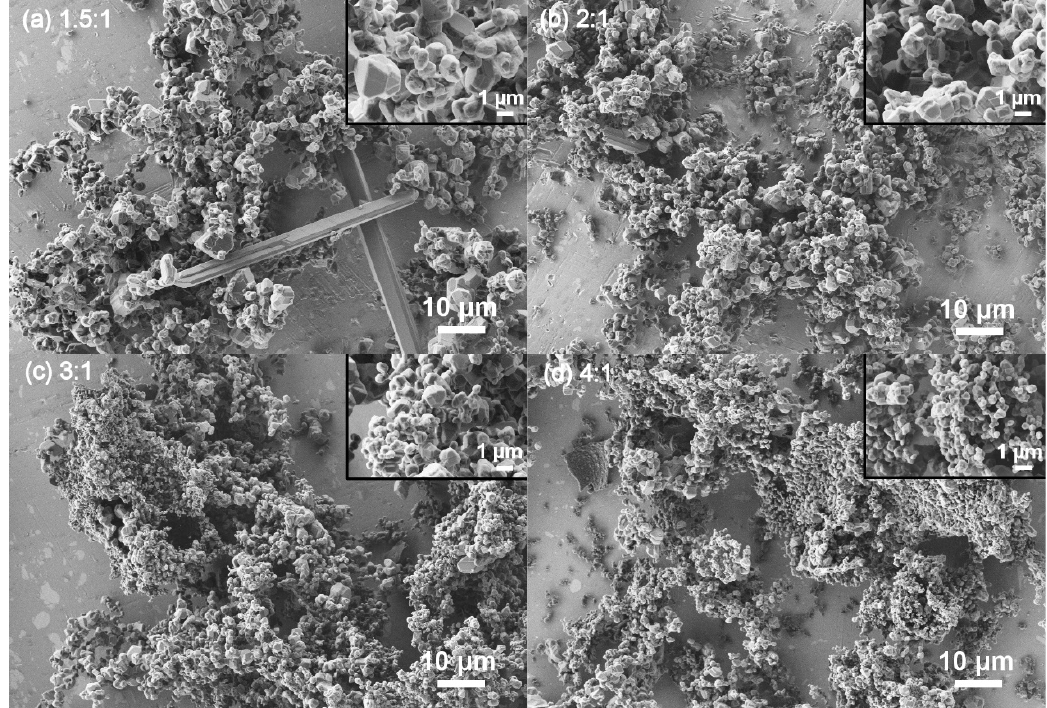
Figure 7. SEM micrographs of B 4 C powders synthesized at 1900 °C for 20 min from starting mixtures with different B 2 O 3 /C molar ratios, ( a ) 1.5:1, ( b ) 2:1, ( c ) 3:1 and ( d ) 4:1.